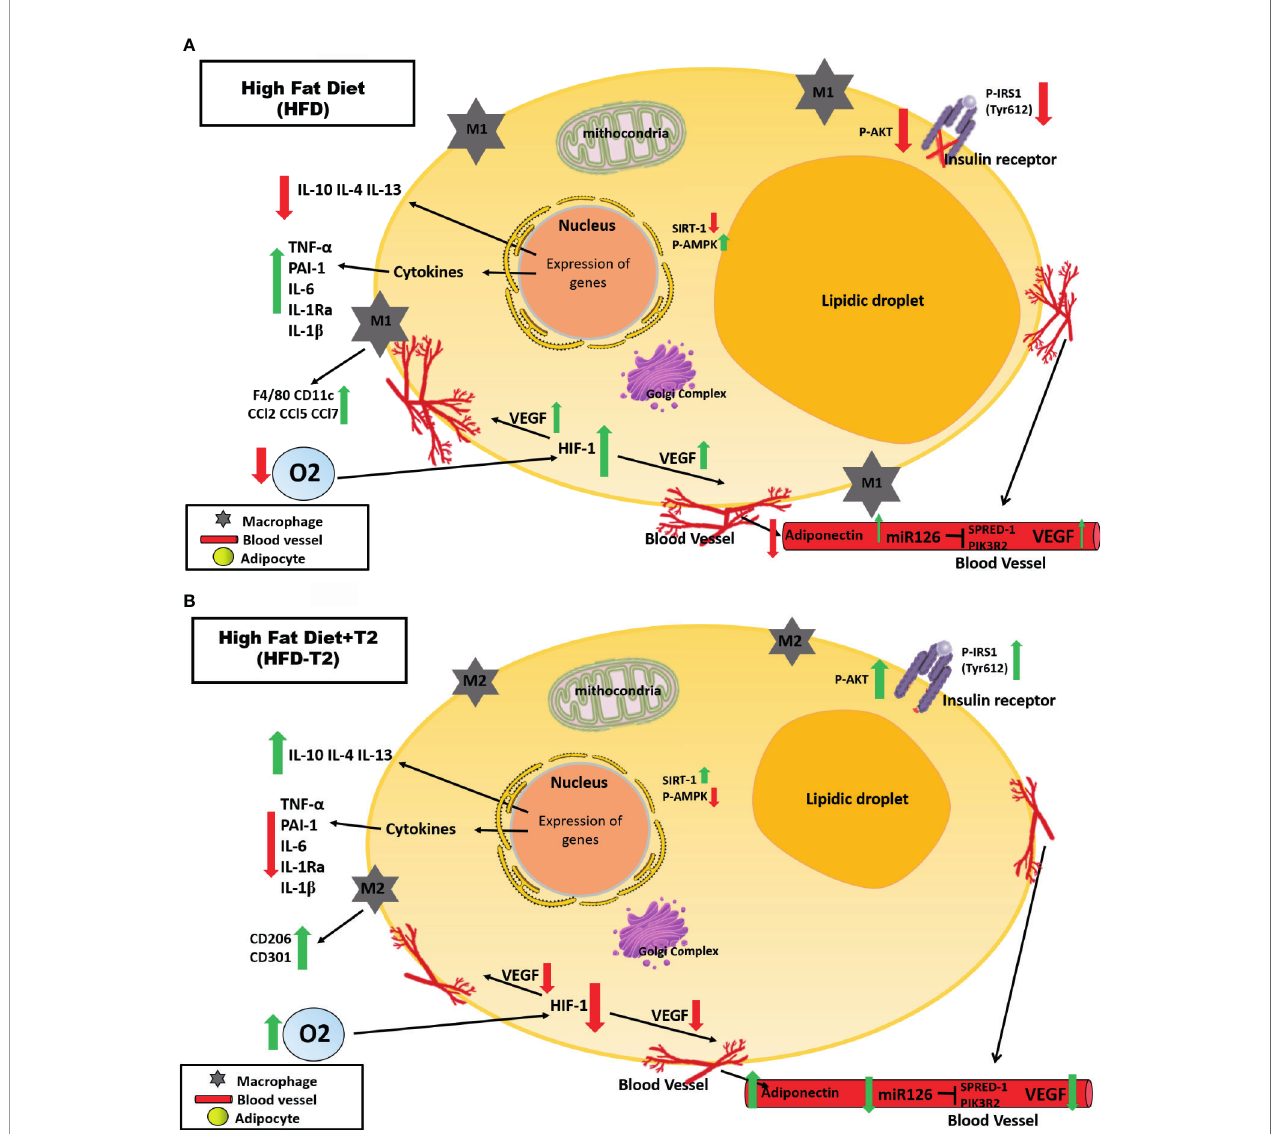
FIGURE 9 | Schematic representation of the effects exerted on adipocytes in vWAT by A) High Fat Diet (HFD) for 14 weeks and B) by High Fat Diet for 14 weeks and T2 administered daily during the last 4 weeks (HFD-T2). In vWAT from overweight rats, hypoxia induces the synthesis of several angiogenic factors (e.g.,VEGF-A) and the expression of in fl ammatory cytokines (e.g., TNF-A, IL-6) while decreasing the expression of adiponectin. In this way, a vicious circle is established in which the activation of angiogenesis fi rst determines a further increase in adipocyte volume and, subsequently, an increase in the in fl ammatory state of the adipose tissue. In overweight rats treated with T2, the in fl ammatory state is reverted. The diiodothyronine is able to reduce the expression of in fl ammatory cytokines and the macrophage in fi ltration producing at the same time a phenotypic switching from M1 pro-in fl ammatory to M2 anti-in fl ammatory macrophages. Moreover, while HFD is associated with increased levels of circulating miR126, T2 administration results in a signi fi cant down representation of such marker of angiogenesis. These fi ndings highlight the ability of T2 to reverse the in fl ammatory state induced by the